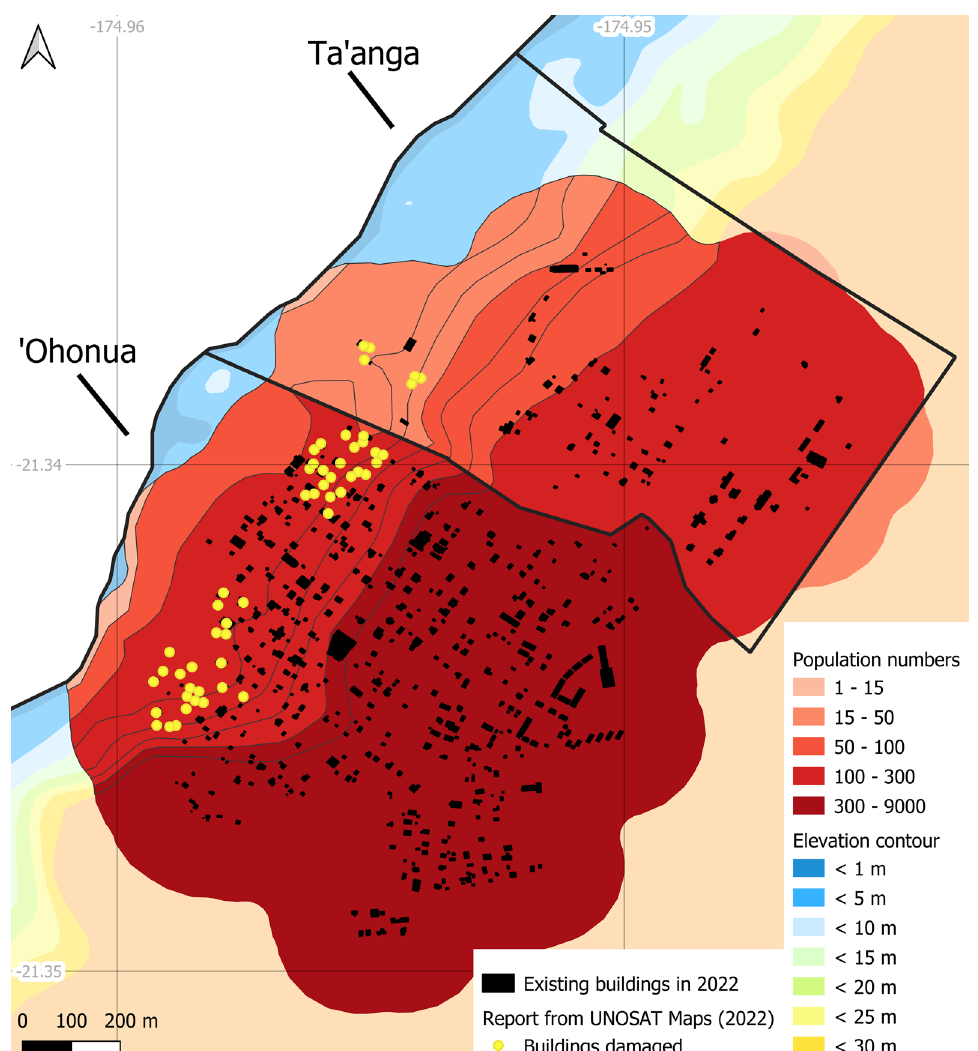
Fig. 7 Detailed map of individual buildings damaged by the 2022 tsunami on ‘Eua island. Gray polygons: buildings included in this study (OCHA 2022c). Yellow dots: buildings confirmed damaged by UNOSAT Maps